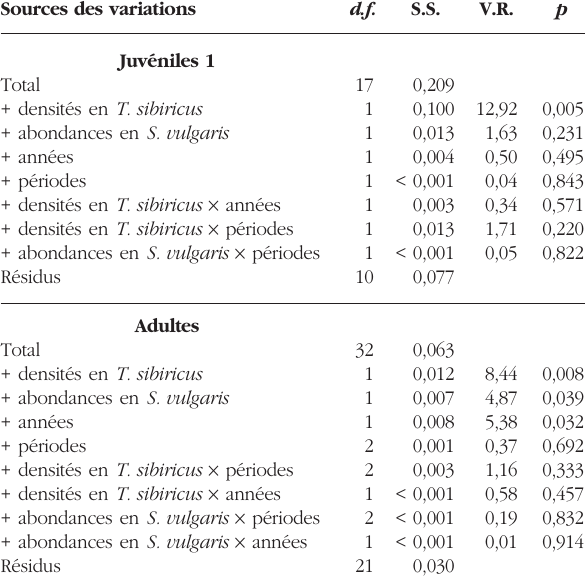
une femelle capturée en février 2006 hébergeant 25 C. a. impavidus . La prise en compte de cet indi- vidu modifiant les résultats, il a été exclu des analyses suivantes. Dès lors, leur abondance est de 0,04 ± 0,01 puces par tamia (n = 1865 : variance = 0,06). Le meilleur modèle expliquant la variation de leur abon- dance est l’âge des tamias (tableau III). Les J2 héber- gent plus de puces (n = 279 : 0,08 ± 0,02) que les J1